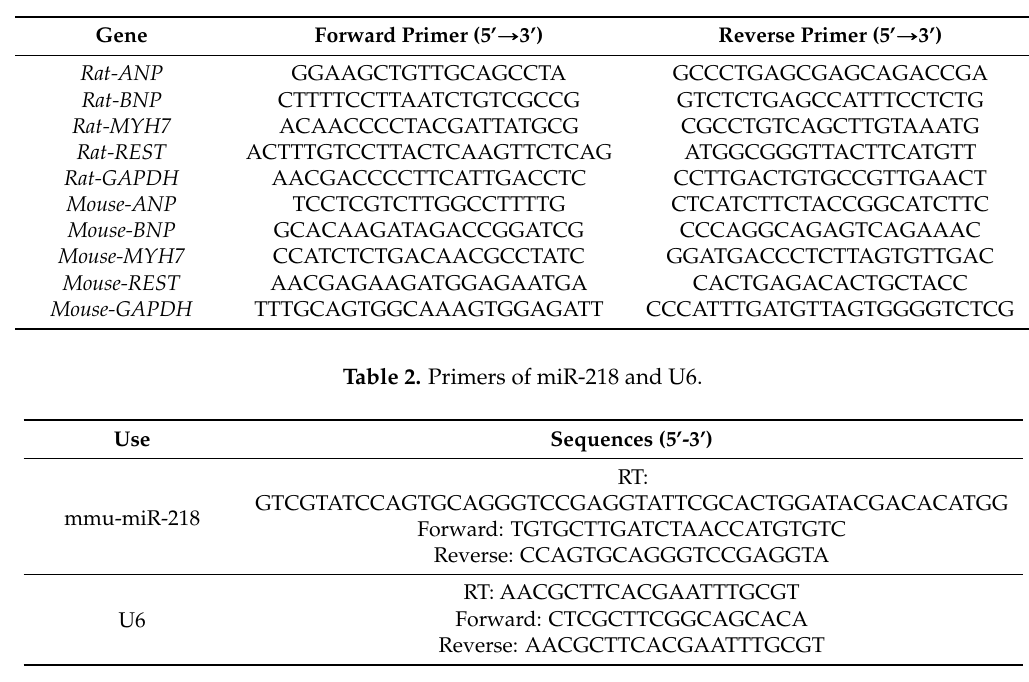
Table 1. Real-time PCR primer sequences.